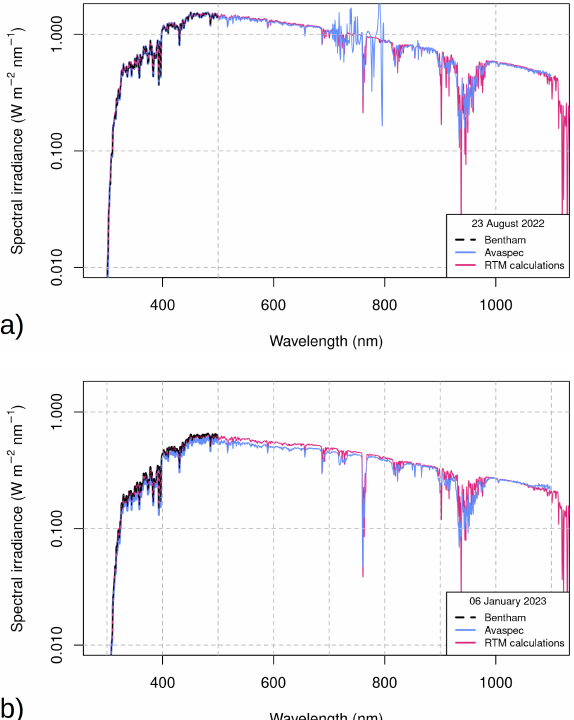
Figure 10. Comparison of the spectral irradiance measured by the Bentham (dashed black line) and by the Avaspec (blue line) with the output of the radiative transfer model (pink line): ( a ) 23 August 2022 (11:30 UTC). The calibration used here in the 290–500 nm range for the AvaSpec was obtained by transfer from the Bentham, while irradiance in the range of 500–1100 nm is based on calibration with a 1000 W lamp; ( b ) 6 January 2023 (12 UTC). Irradiance in the 290–500 nm range was